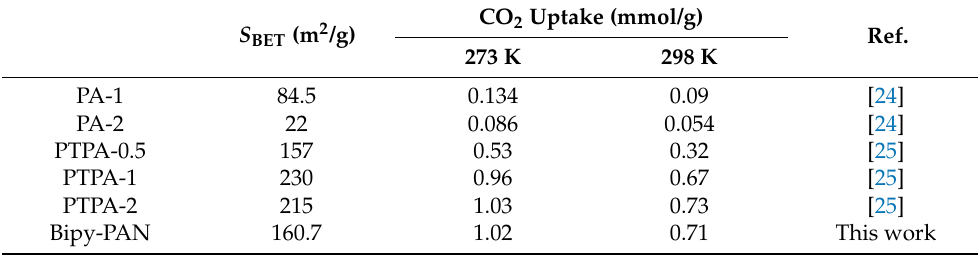
Figure 7. CO 2 uptake isotherms of Bipy-PAN obtained at 273 and 298 K. Table 1. The S BET surface area and the CO 2 uptake of various melamine-based POPs.